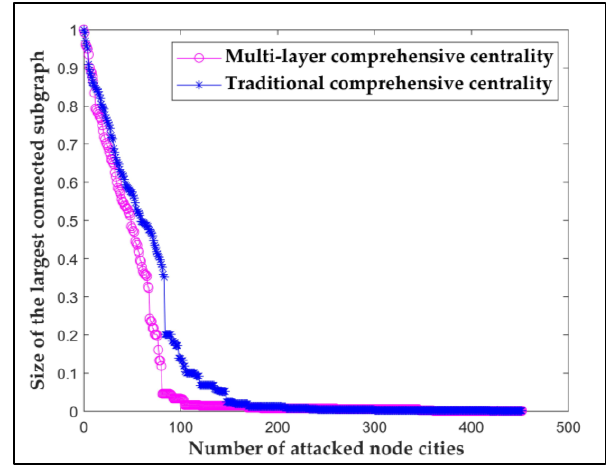
Figure 9. Attacks results of different comprehensive centrality.